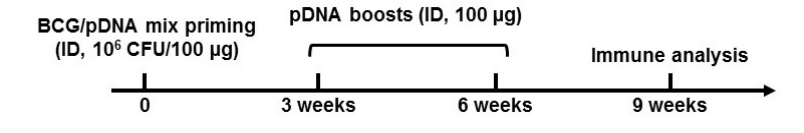
Figure 1. BCG/pDNA co-vaccination protocol. Priming was performed in adult mice with a mix of 10 6 CFU live M . bovis BCG and 100 µg coding or non-coding plasmid DNA by the intradermal route in the tail (ID). After 3 weeks of resting, two further boosts at